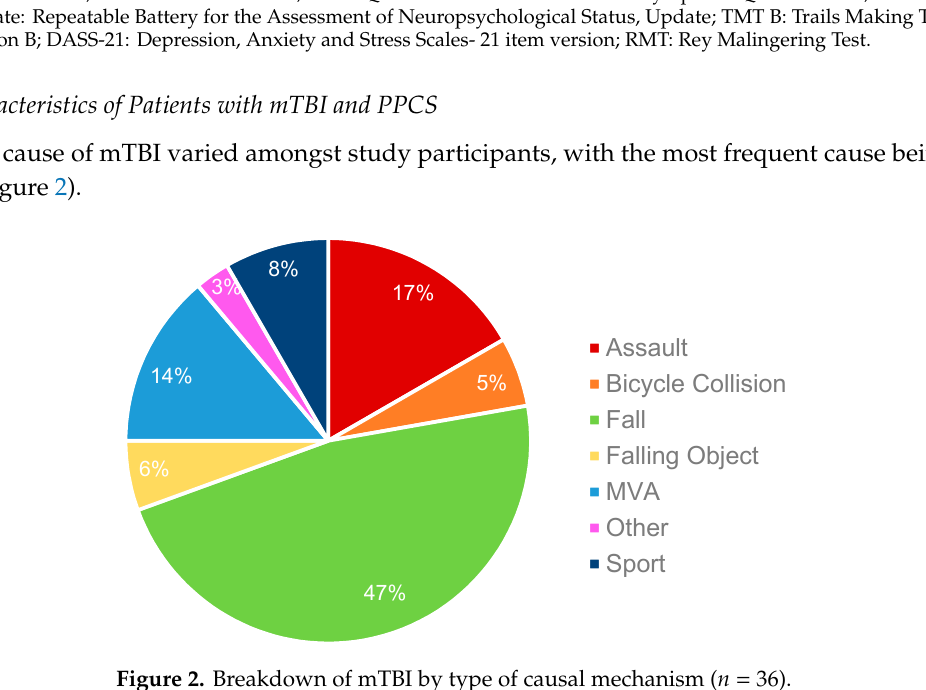
Table 2. Demographic variables, injury-related characteristics, and performance on